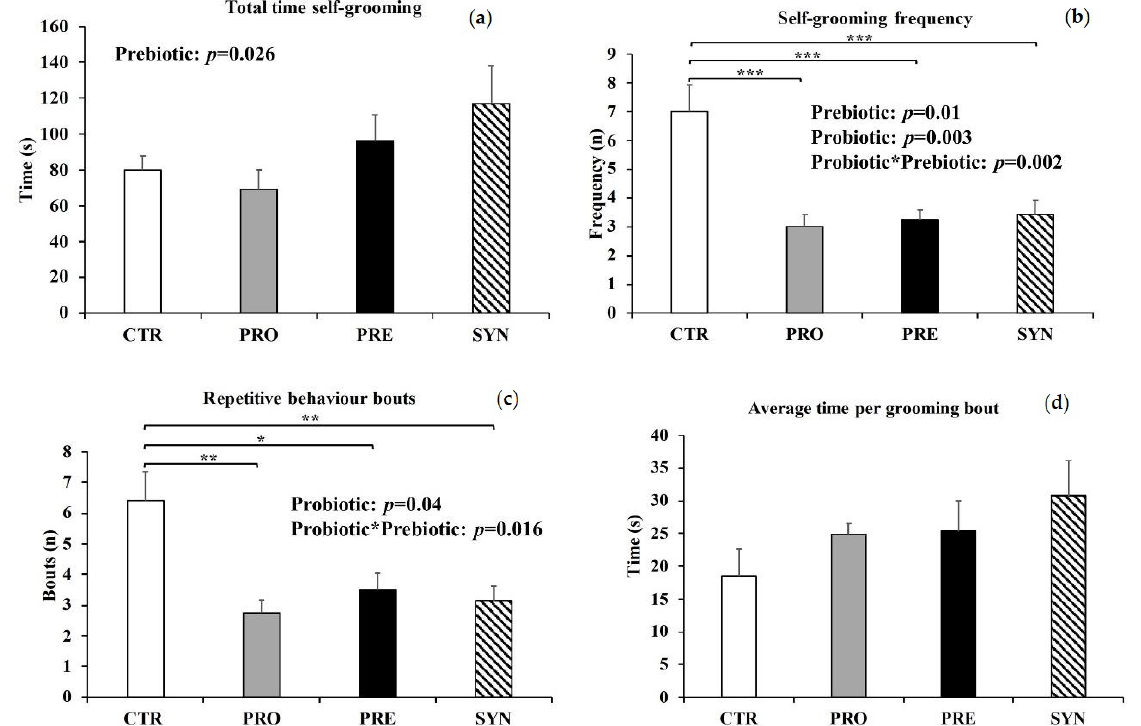
Figure 4. Self-grooming behaviors at postnatal day 42–43 in BTBR mice consuming either a control, probiotic, prebiotic, or synbiotic diet for three weeks. ( a ) Total time spent self-grooming; ( b ) self-grooming frequency; ( c ) repetitive behavior bouts; ( d ) average time per grooming bout. Values or mean ± SEM, n = 8–10/group. P-values presented in the figure represent the main effects and interaction effects from the two-way ANOVA. * p ≤ 0.05; ** p < 0.025; *** p < 0.0005. CTR, control; PRO, probiotic; PRE, prebiotic, SYN, synbiotic.